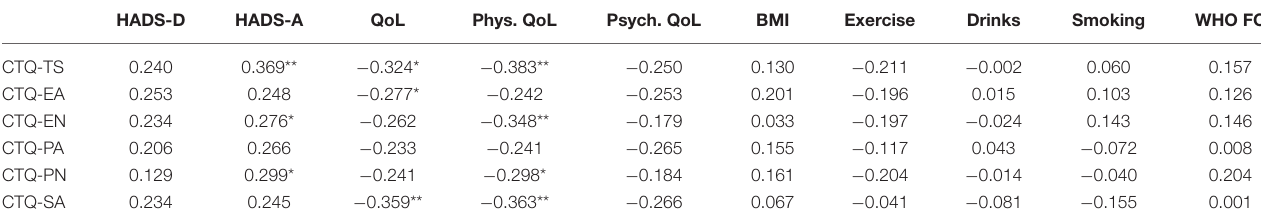
TABLE 3 | Partial correlation (Spearman’s r ) of CTQ-Scores in CTEPH with HADS, QoL, Lifestyle, and WHO FC adjusted for age and gender.